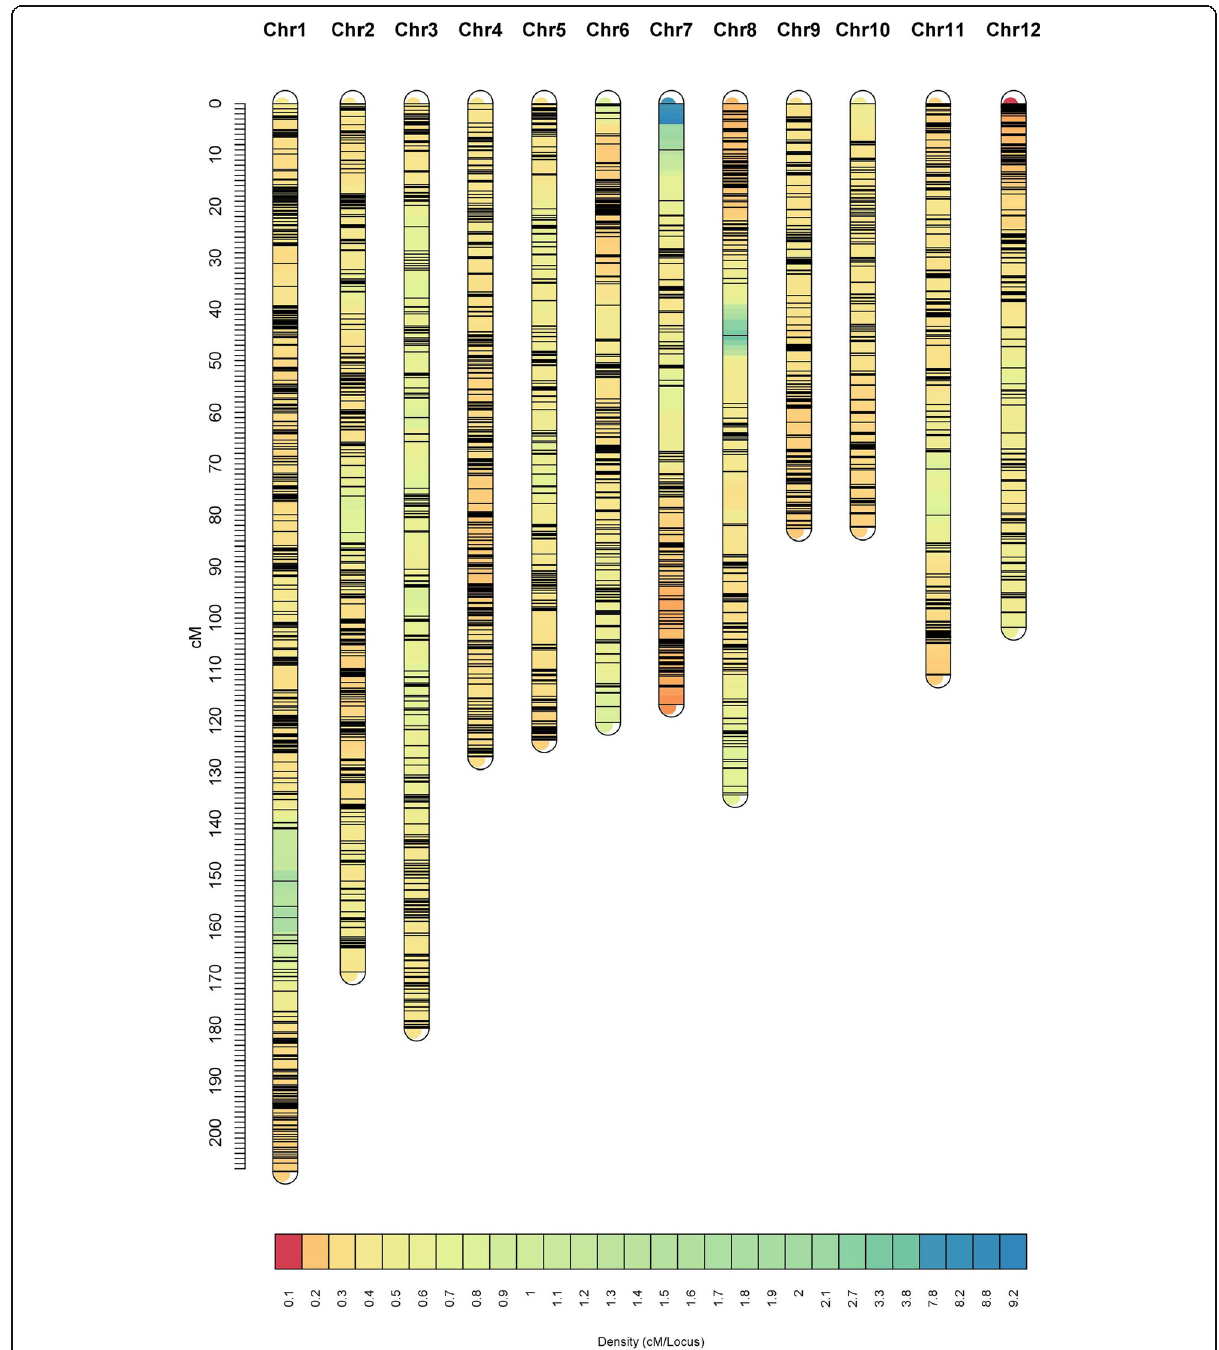
Fig. 4 Linkage map constructed by GAPL from